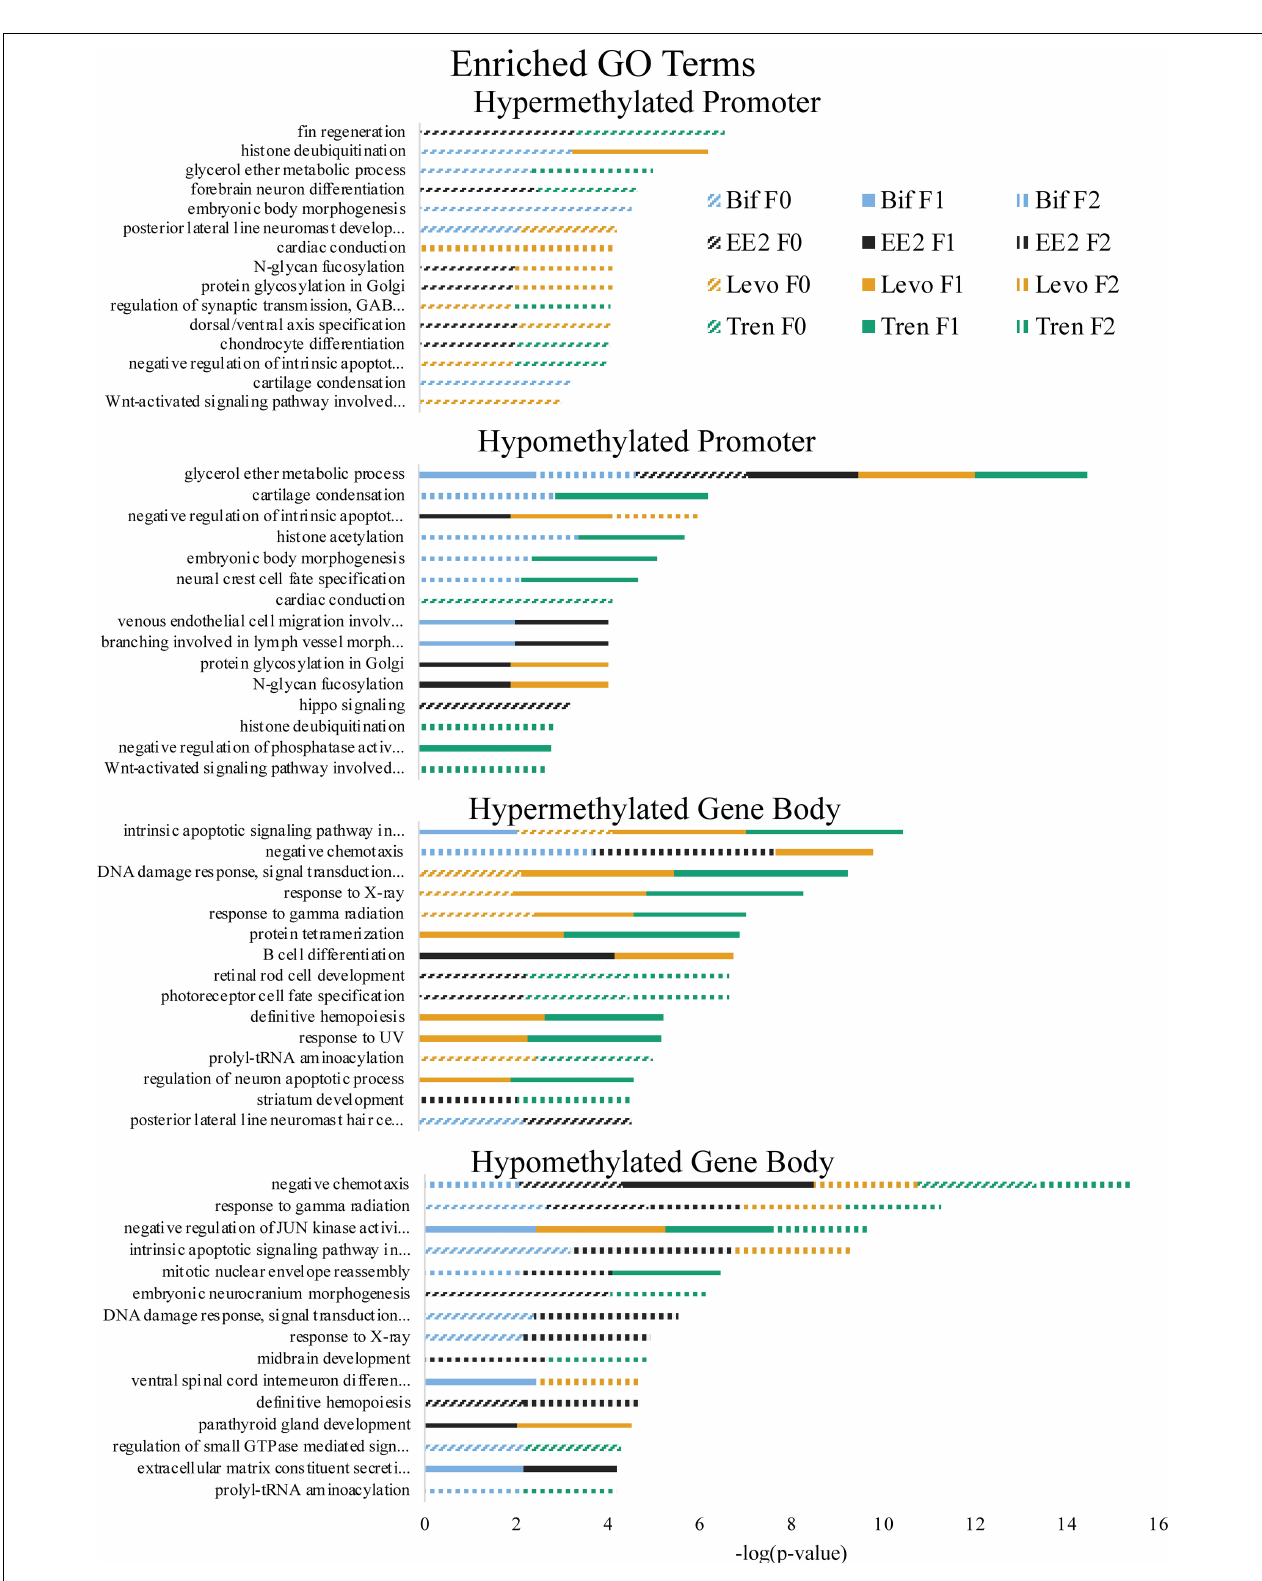
FIGURE 4 | Enriched Gene Ontology (GO) Terms by directional methylation change relative to the control (hyper, hypo), gene region (promoter, gene body), treatment (Bif, EE2, Levo, Tren), and generation (F0, F1, F2) showing level of significance based on Fisher’s exact test p -values.